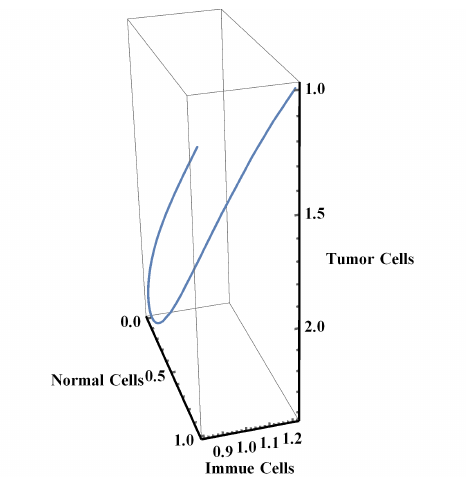
Figure 2. The parametric solution of the normal-tumor-immune-unhealthy diet model (NTIUNHDM).